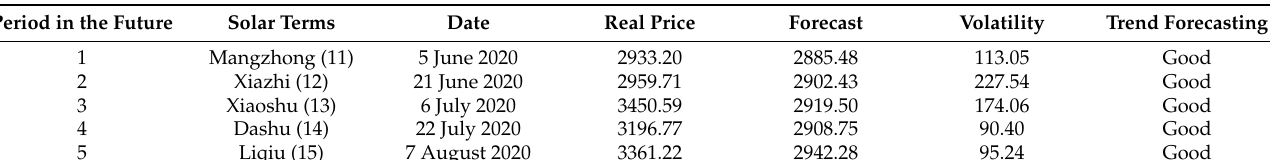
Table 11. Forecasts of the all-terms group of the Shanghai Index.